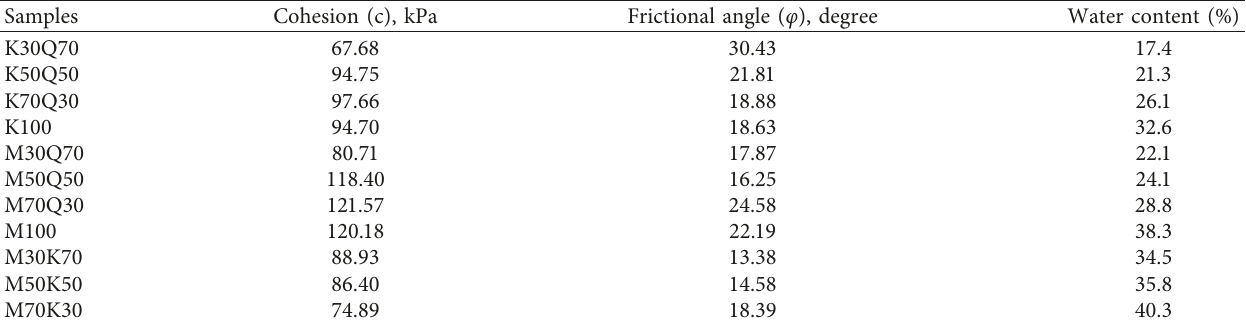
Figure 5: Variation of shear strength with clay proportion in the montmorillonite-kaolin mixture: (a) cohesion and (b) frictional angle. Table 1: Shear strength results with water content for as-compacted